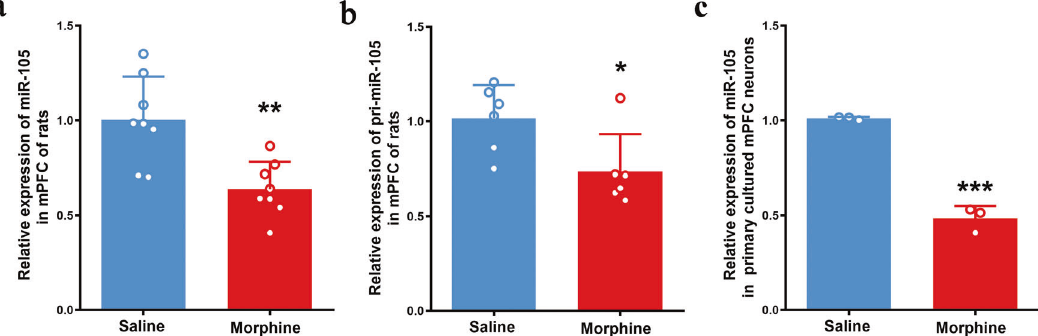
Fig. 1 The effect of chronic morphine on the expressions of miR-105 and pri-miR-105 in rat mPFC and primary cultured mPFC neurons. a The relative expression of miR-105 in rats mPFC of saline and morphine groups ( n = 8 in each group, unpaired two-tailed Student ’ s t -test, ** P = 0.0019). b The relative expression of pri-miR-105 in rats mPFC of saline and morphine groups ( n = 6 in each group, unpaired two-tailed Student ’ s t -test, * P = 0.0268). c The relative expression of miR-105 in primary cultured mPFC neuron of saline and morphine groups ( n = 3 in each group, unpaired two-tailed Student ’ s t -test, *** P = 0.0002). Data are presented as mean ±